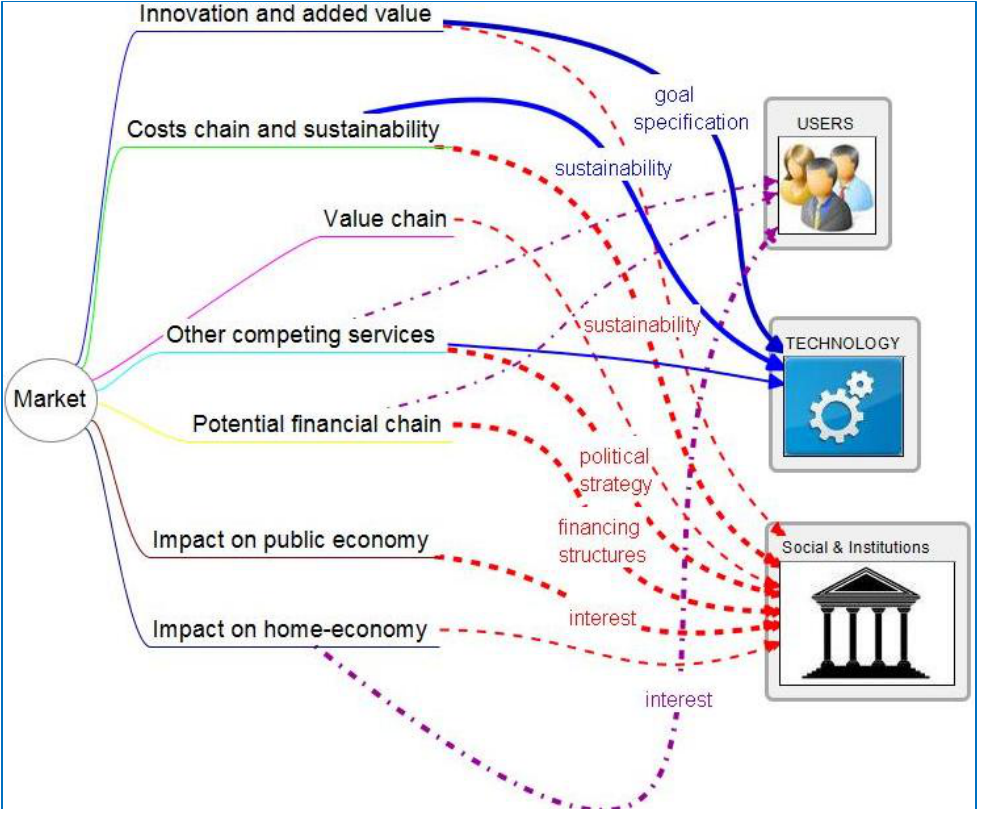
Figure 4. Cross relation of information-bits generated by market-oriented professionals among different professional